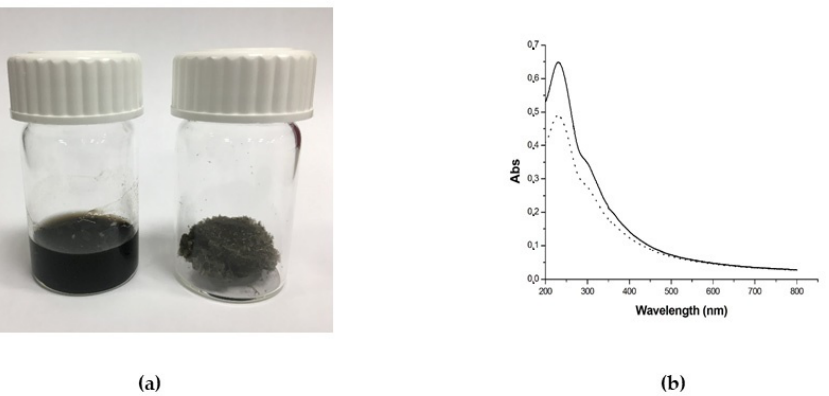
Figure 12. ( a ) Photograph of GO aqueous dispersion 1 mg/mL (left) and the obtained GO sponge after freeze-drying process (right) and ( b ) UV-Vis spectra of GO aqueous dispersion before freeze-drying (straight line) and GO aqueous dispersion obtained by redispersion of GO sponge (dotted line). The decrease of the absorbance after lyophilization is due to the loss of material during the process.